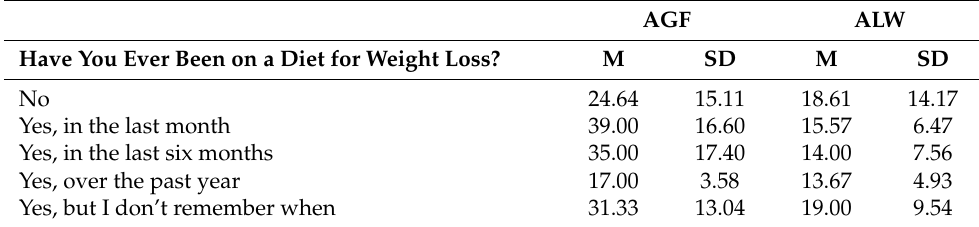
Table 4. Frequency of dietary intake and mean AGF and ALW